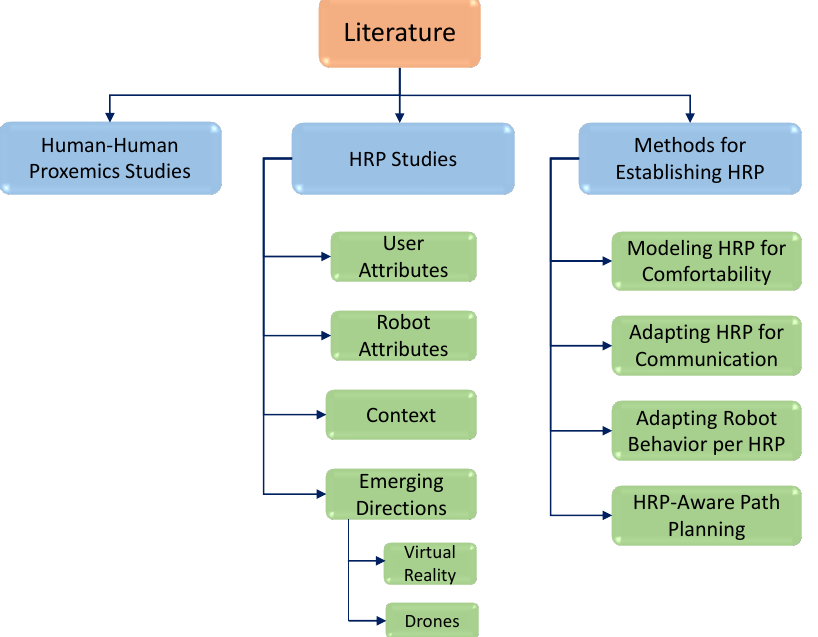
Figure 2. Taxonomy used in this paper to analyze the proxemics